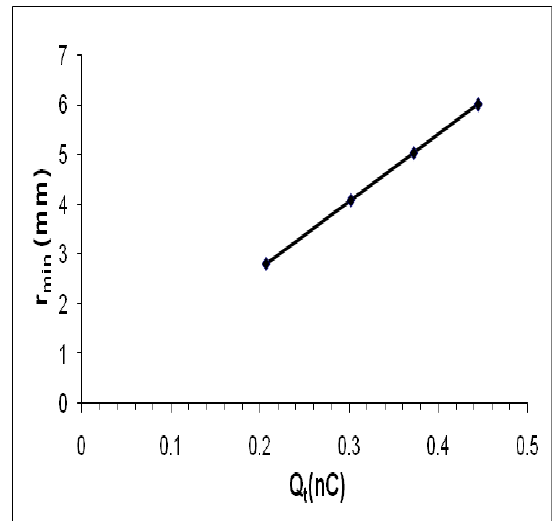
Fig.6: Variation of the reflection point with trapped